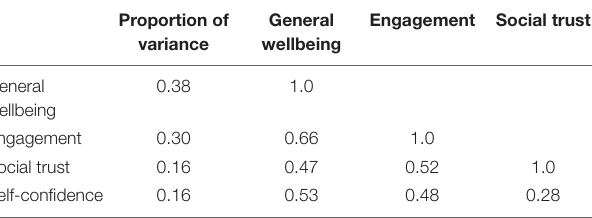
TABLE 4 | EFA: factor correlations and proportion of variance accounted for.